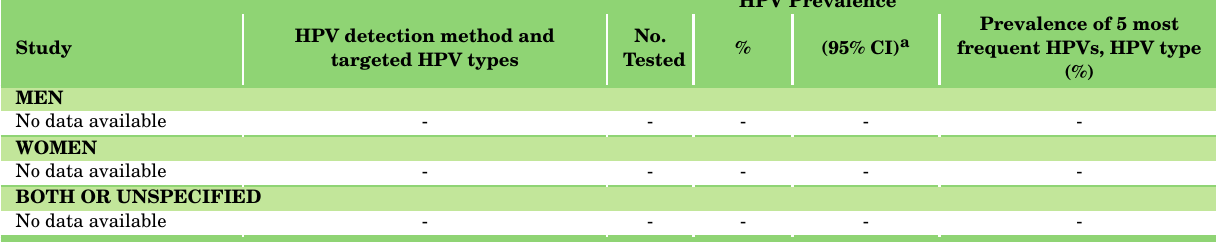
Table 36: Studies on HPV prevalence among cases of oral cavity cancer in Peru